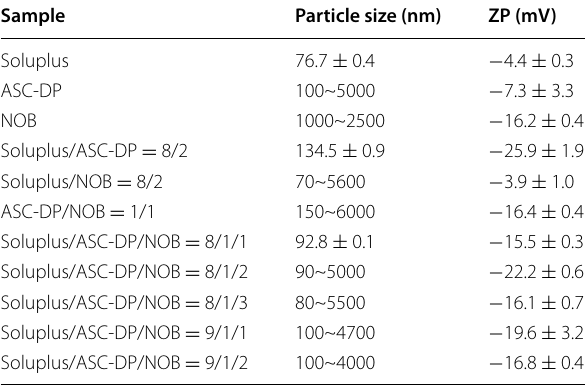
Results are expressed as mean